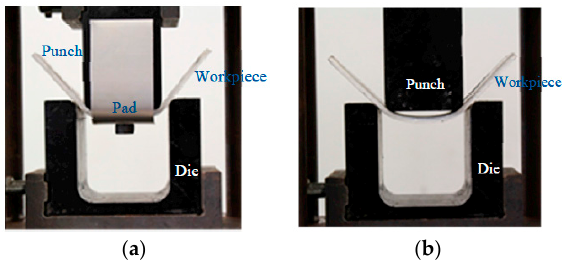
Figure 3. U-die sets for the experiments: ( a ) without pressure pad and ( b ) with pressure pad.